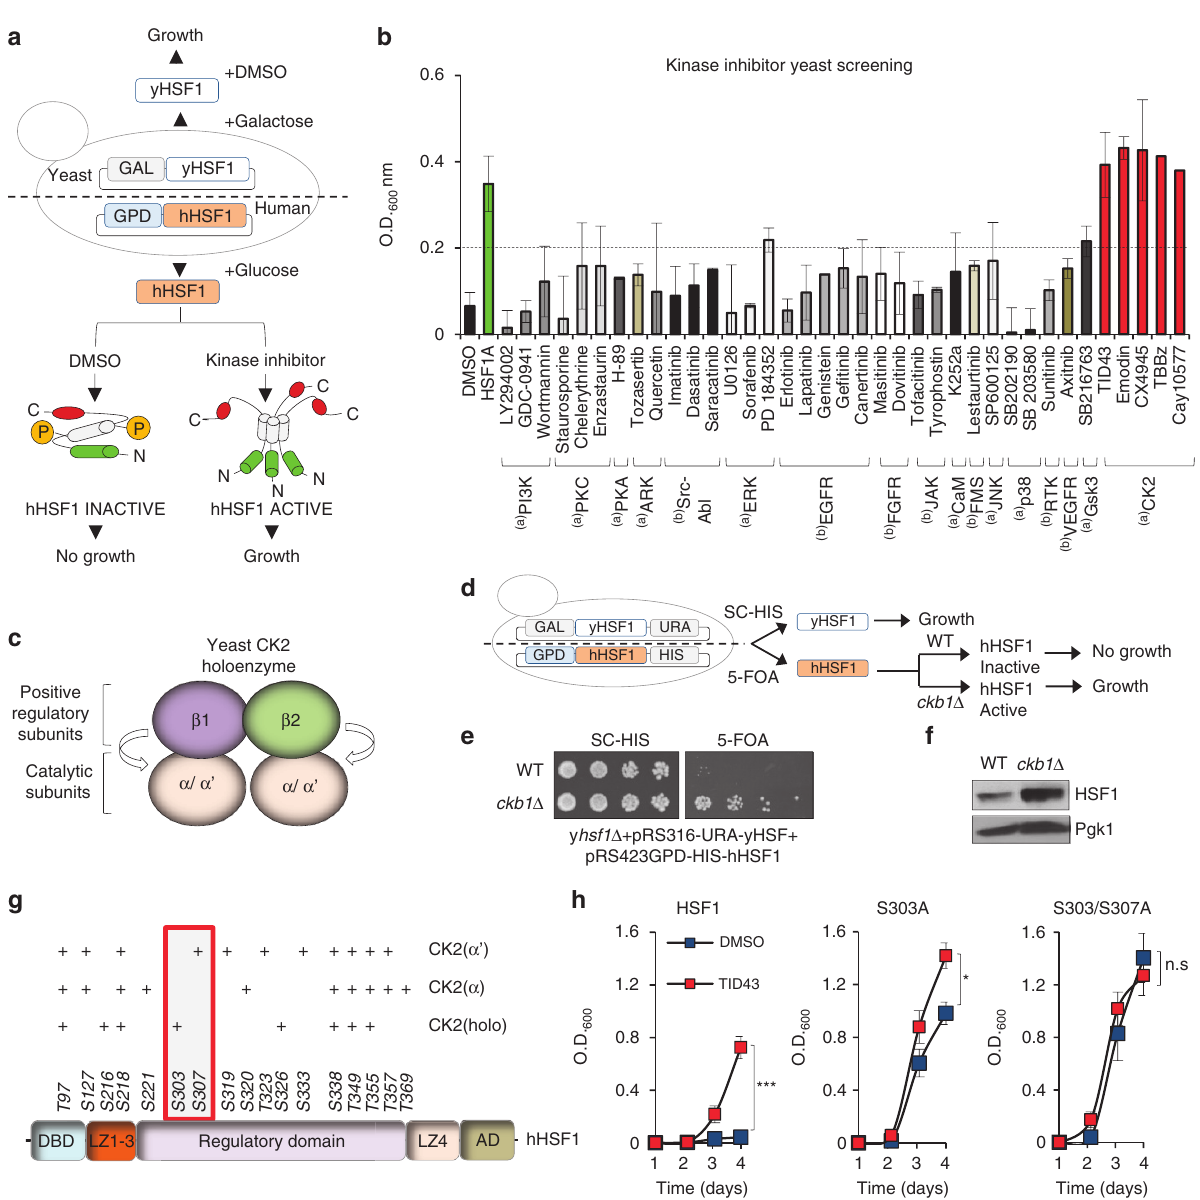
NATURE COMMUNICATIONS|8:14405|DOI: